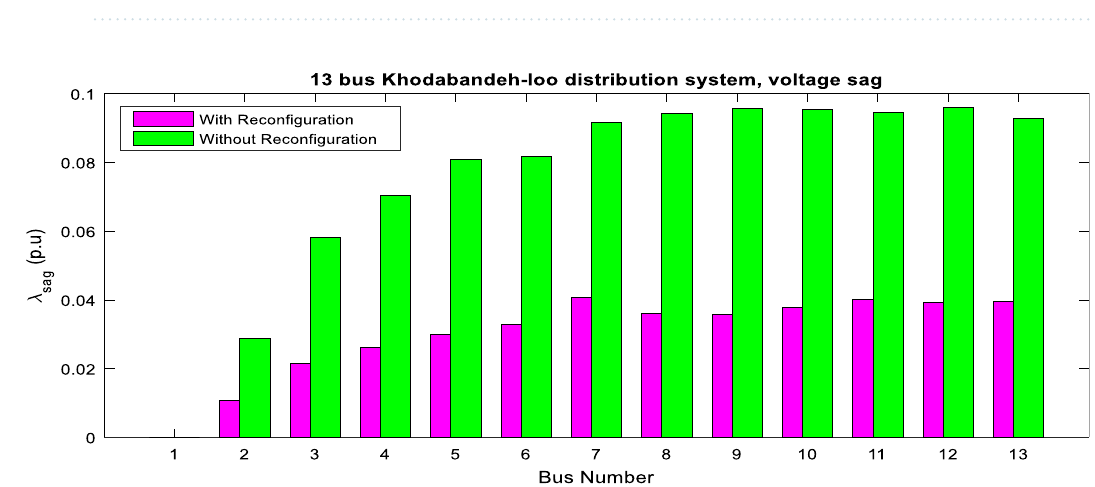
Figure 5. The optimal objective values obtained with different algorithms for the unbalanced 13-bus